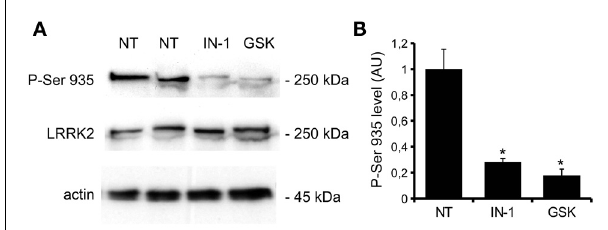
FIGURE 1 | IN-1 and GSK inhibit LRRK2 activity ex-vivo . (A) Acute hippocampal slices were incubated in regular aCSF (NT) or in aCSF + IN-1 (IN-1) or GSK (GSK) both 1 µ M for 2h at RT. Slices were then solubilized and assayed by western blotting for P-Ser 935, LRRK2 and actin